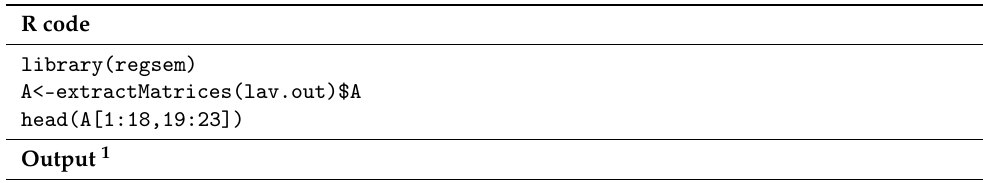
Table 2. R code and output for extracting the RAM matrices and determining the numbering of parameters to be penalized.